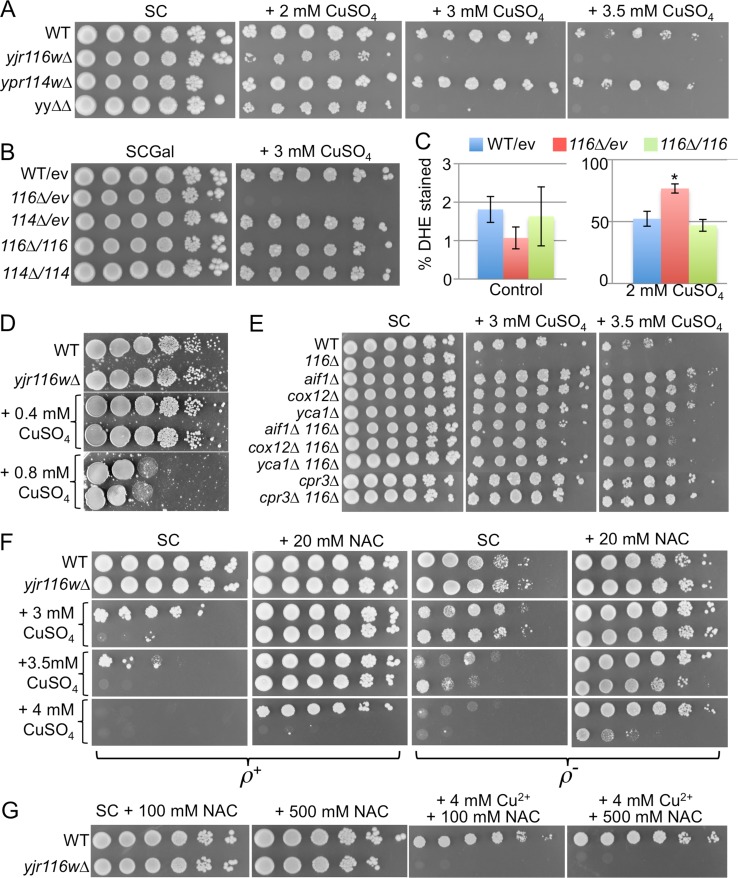
Disruption of YJR116w makes cells hypersensitive to copper.A. 10-fold serial dilutions of yjr116w∆, ypr114w∆ and yy∆∆ mutants were plated on SC containing 2% glucose and indicated concentrations of CuSO4. B. WT, yjr116w∆ (116∆), or ypr114w∆ (114∆) cells harboring either empty pYES2NT vector (ev) or the same expressing YJR116w or YPR114w (114 or 116, respectively), were plated on SC with 2% galactose (Gal). C. Superoxide anion (O2-) levels of three independent clones of the same strains grown for 15 h in presence or absence of 2 mM CuSO4 were assessed by staining cells with DHE. * yjr116w∆ cells showed a significantly higher percentage of DHE positive cells than WT (P = 0.0039). D. As A, but plates were incubated anaerobically and contained 5 mg ml-1 Tween 80 and 20 μg ml-1 ergosterol. The freckles are precipitates caused by these additions to the medium. In each plate section, in the upper and lower rows are WT and yjr116w∆ cells, respectively. E. Copper sensitivity of indicated mutants was tested as in A. F. First and 3rd columns as in A, the others supplemented additionally with 20 mM NAC. The 3rd and 4th columns show the growth behavior of ρ- strains lacking the respiratory chain. G, growth on copper and higher concentrations of NAC.